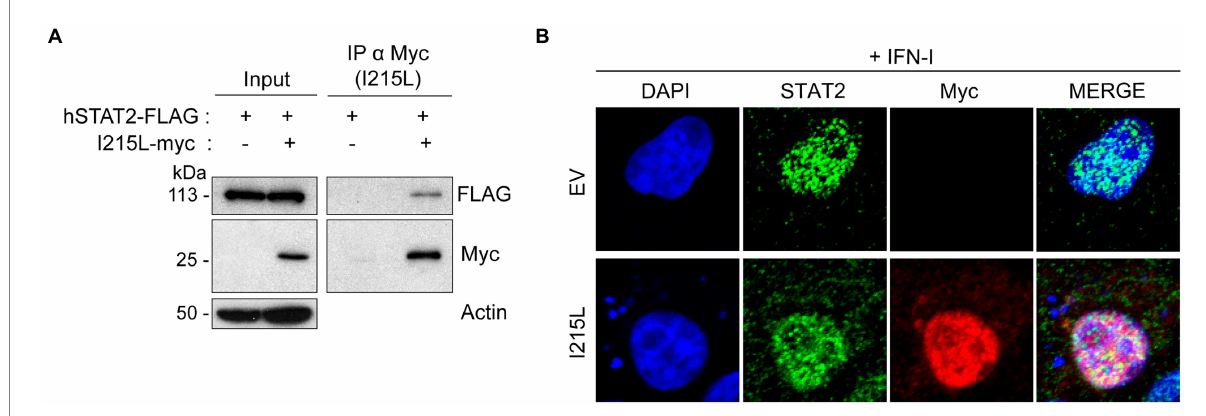
FIGURE 2 pI215L colocalizes with STAT2 at the nucleus. (A) hSTAT2-FLAG interacts with pI215L in BSRT7 cells. BSRT7 cells were co-transfected with hSTAT2- FLAG (0.4 μ g/1 × 10 6 cells) and with pIRES-I215L-myc (2 μ g/1 × 10 6 cells). 24 h post-transfection, cells were stimulated with Universal Type I IFN (500 U/ mL) for 1 h. Cells were then collected and processed for immunoprecipitation with an anti-myc antibody and analyzed by Western blot labeling with antibodies against FLAG to detect STAT2, against myc to detect pI215L and against actin. (B) pI215L colocalizes with STAT2 in the cell nucleus. Vero cells were transfected with EV or pIRES-I215L-myc (2 μ g/1 × 10 6 cells) expression plasmids. After 24 h, cells were stimulated with IFN-I (250 U/ mL) for 1 h. After treatment, cells were fixed and stained with DAPI (blue), anti-STAT2 (green) and anti-myc (I215L; red) antibodies and examined by a confocal microscope. Merged images of the different channels are also